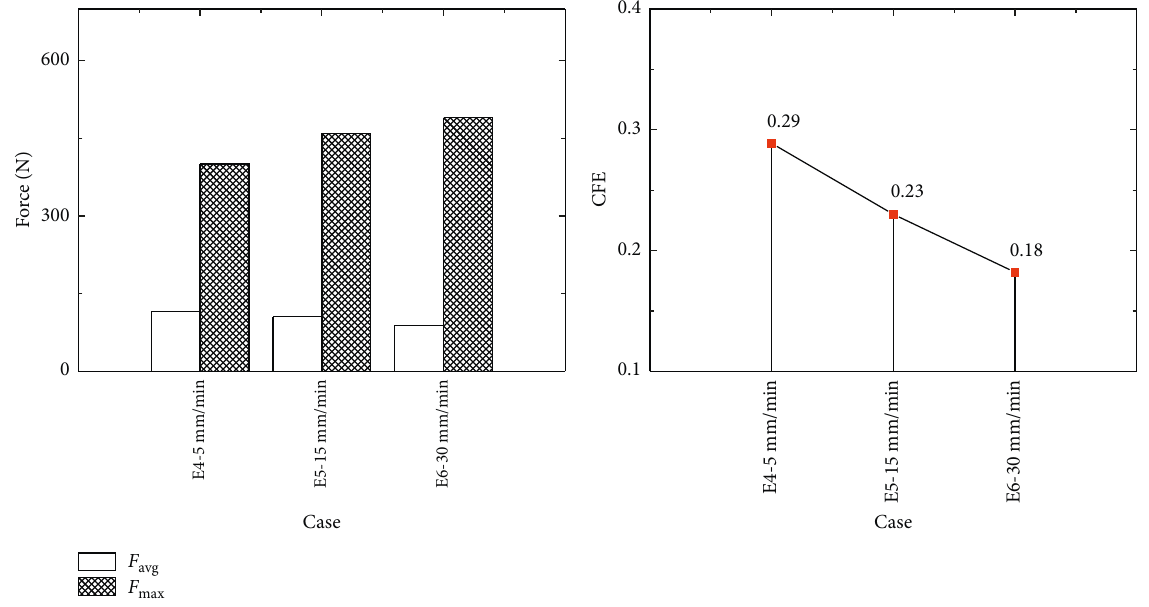
Figure 15: Comparison of different loading velocities for specimens: F